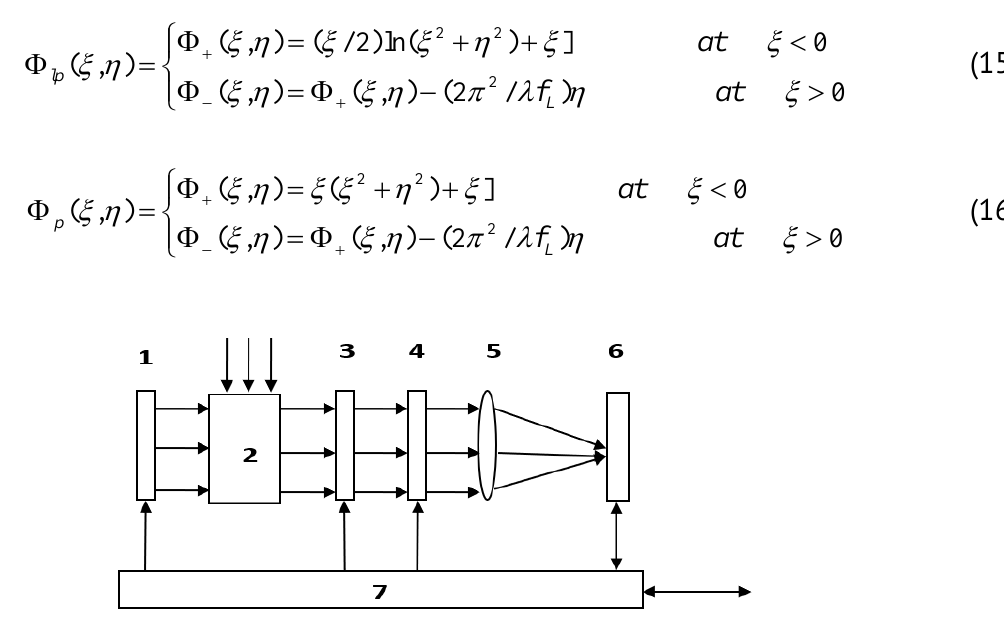
Figure 4. Optical processor for integral image chord